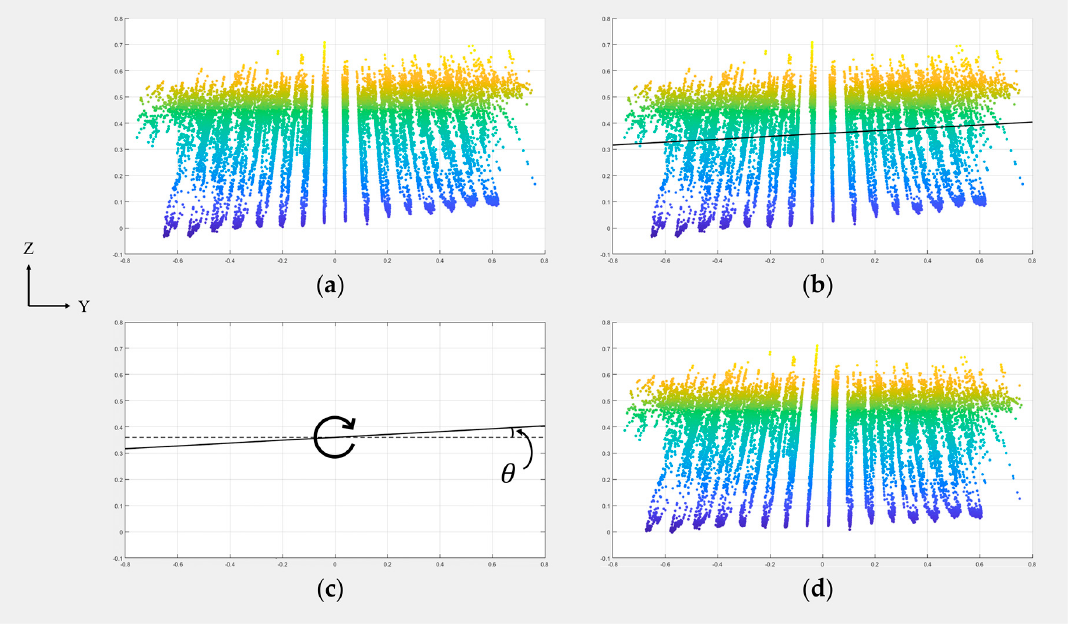
Figure A1. An example of Y-Z plane rotation correction: ( a ) Point cloud before rotation; ( b ) Fit a linear curve to points on Y-Z plane; ( c ) Rotate points on Y-Z plane by the angle θ ; ( d ) Point cloud after rotation.